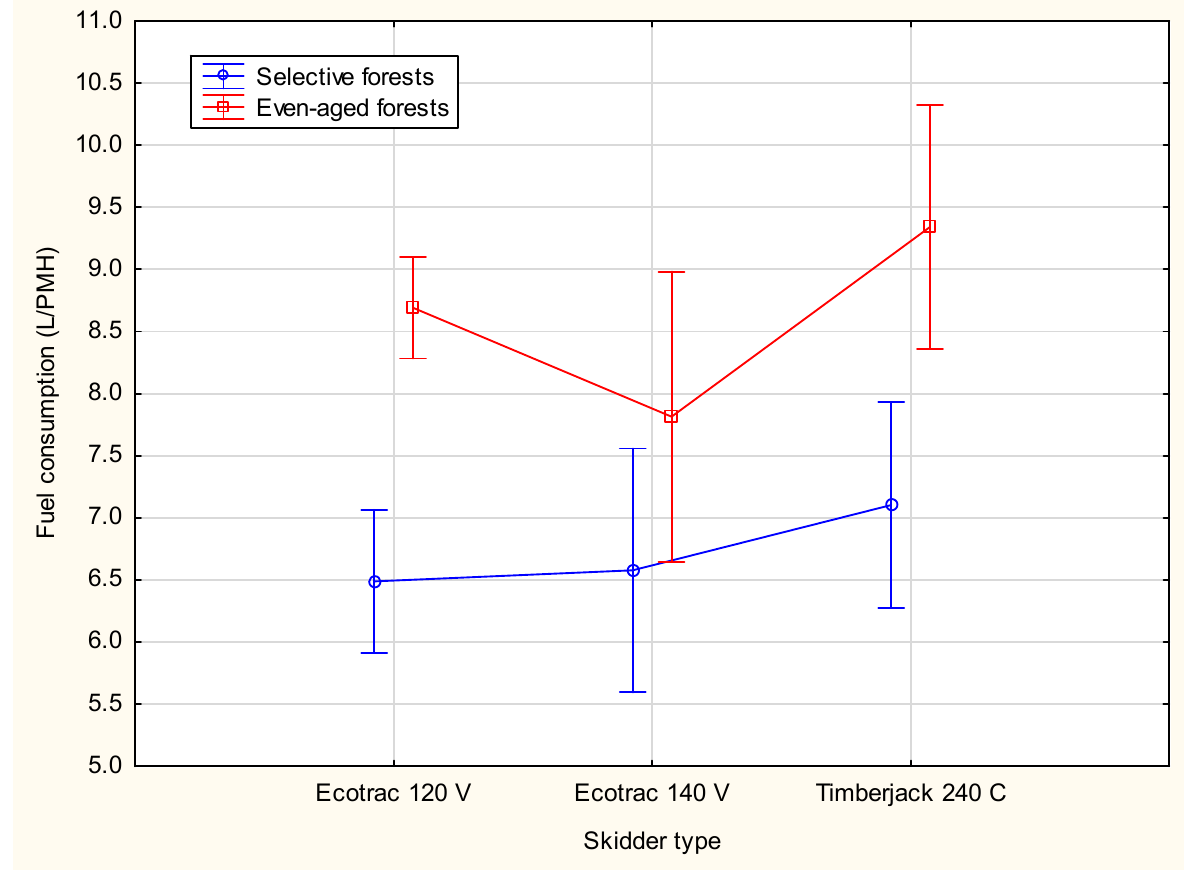
Figure 2. Fuel consumption expressed in L/PMH.